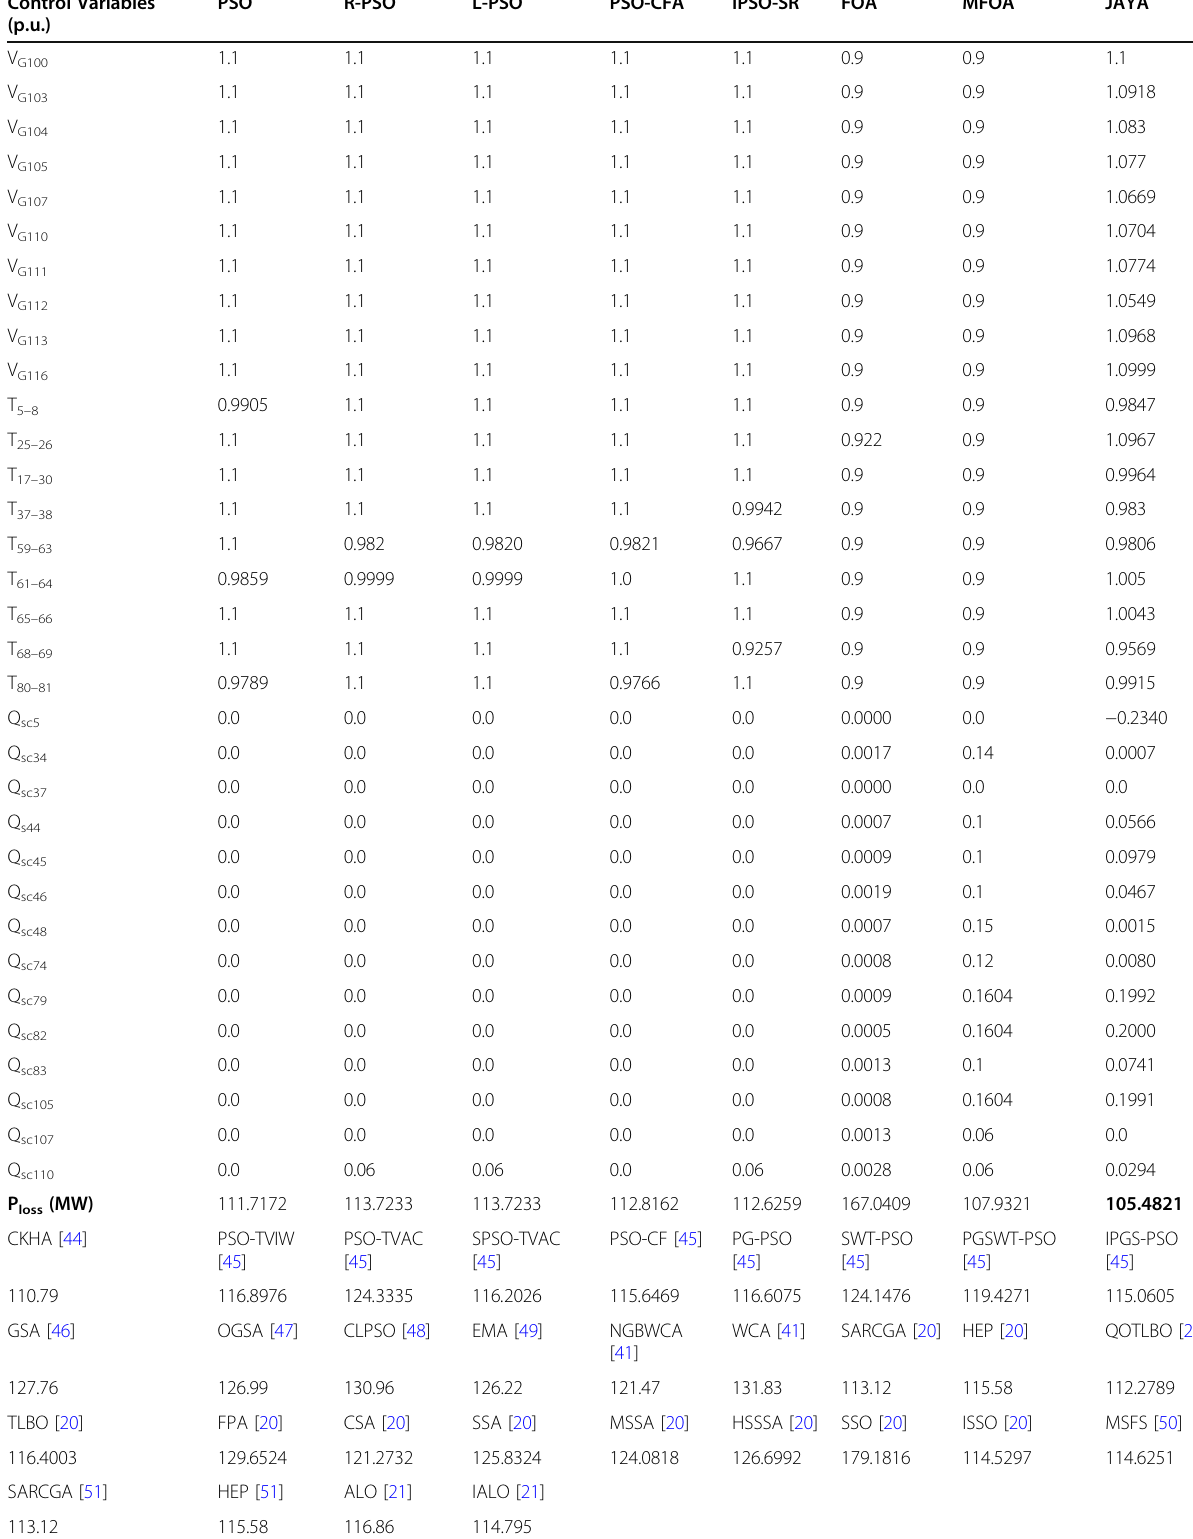
Table 10 Simulation results on the IEEE 118 bus system using different algorithms without DG injection (Continued) Control Variables